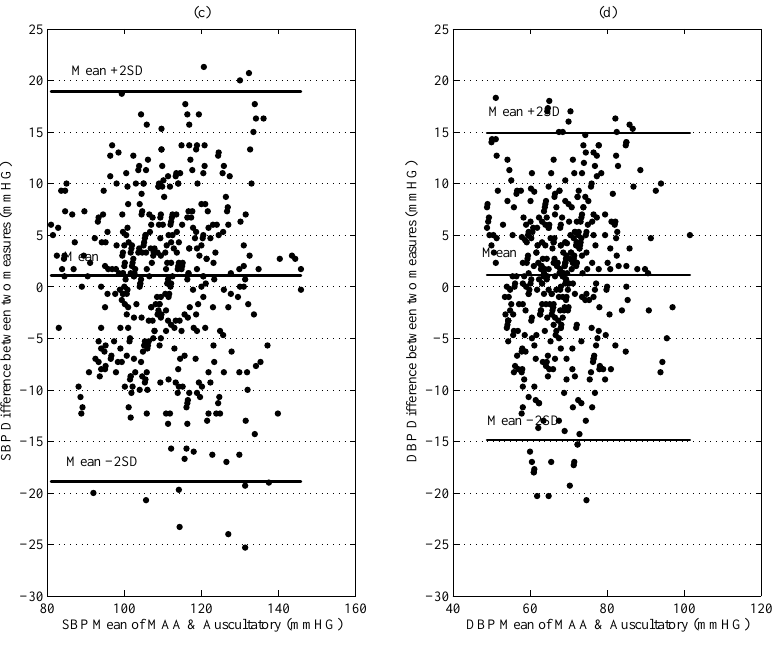
Figure 6. Bland-Altman plots comparing of the performance between thr conventional MAA and auscultatory results, ( a ) Bland-Altman plot for the SBP and ( b ) Bland-Altman plot for the